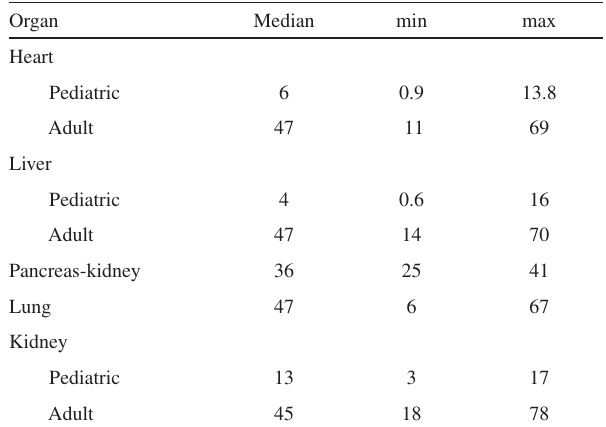
Table 2 - Age distribution (years) of transplant recipients